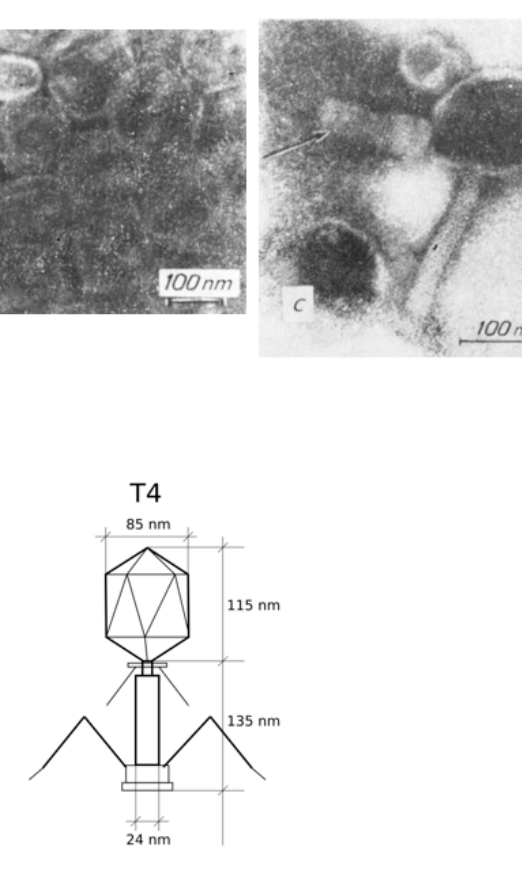
Figure 1. Ultrastructure of phiKZ phage particles after a freezing and thawing procedure: ( a ) Phage particle with a disrupted head. The arrow indicates the inner cylindrical body with loops of fibrous material (perhaps DNA) around; ( b ) The head of a tail-less phiKZ particle with an inner body (the arrow indicates the inner cylindrical body); ( c ) The inner body coming out of the phiKZ particle disrupted by freezing and thawing (arrow) [23]; ( d ) A schematic drawing of phage phiKZ and T4-particles for size comparison.